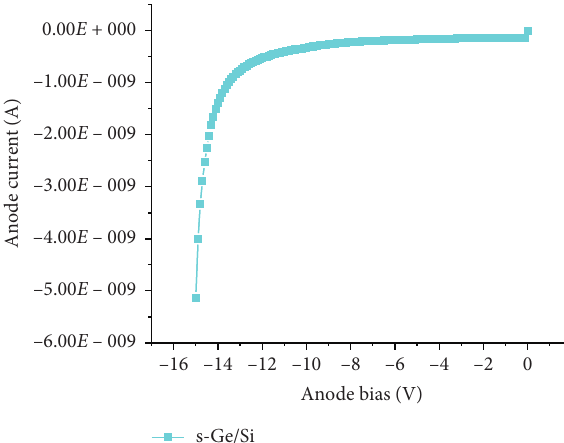
Figure 8: s-Ge/Si Schottky diode breakdown characteristics.